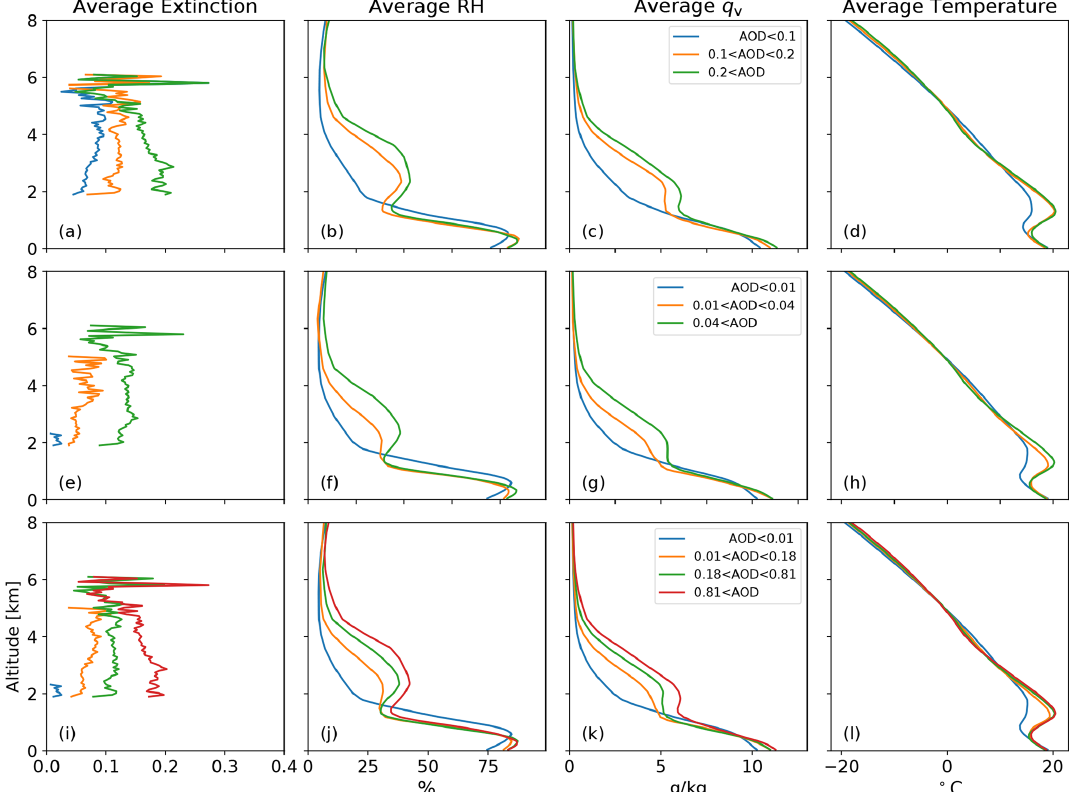
Figure A7. Mean profiles of aerosol extinction, relative humidity (RH), specific humidity ( q v ), and temperature for CALIPSO profiles containing aerosols above clouds during the months June–July–August from 2007 to 2010. The data used for panels (a–d) , (e–h) , and (i–l) are exactly the same. The only difference is the selection of the interval limits and interval number for which the mean values are computed (see Sect. 3.6). The aerosol optical depth (AOD) values are obtained from the CALIPSO Aerosol Profile Data product. RH, q v , and temperature are originally from MERRA-2 and added along the satellite track to the CALIPSO Aerosol Profile Data product.